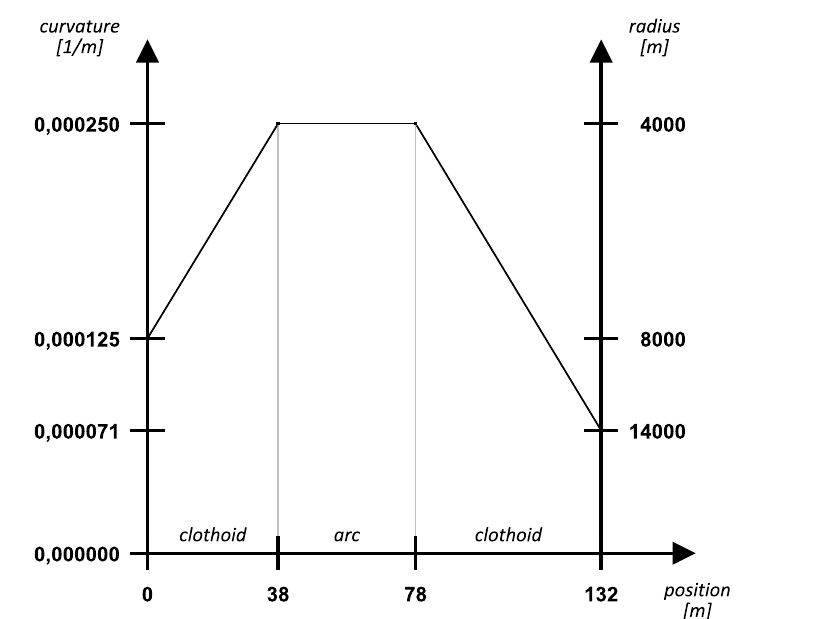
Figure 1. The course of curvature in the turning branch of the J60-1:33,5-8000/4000/14000-PHS turnout